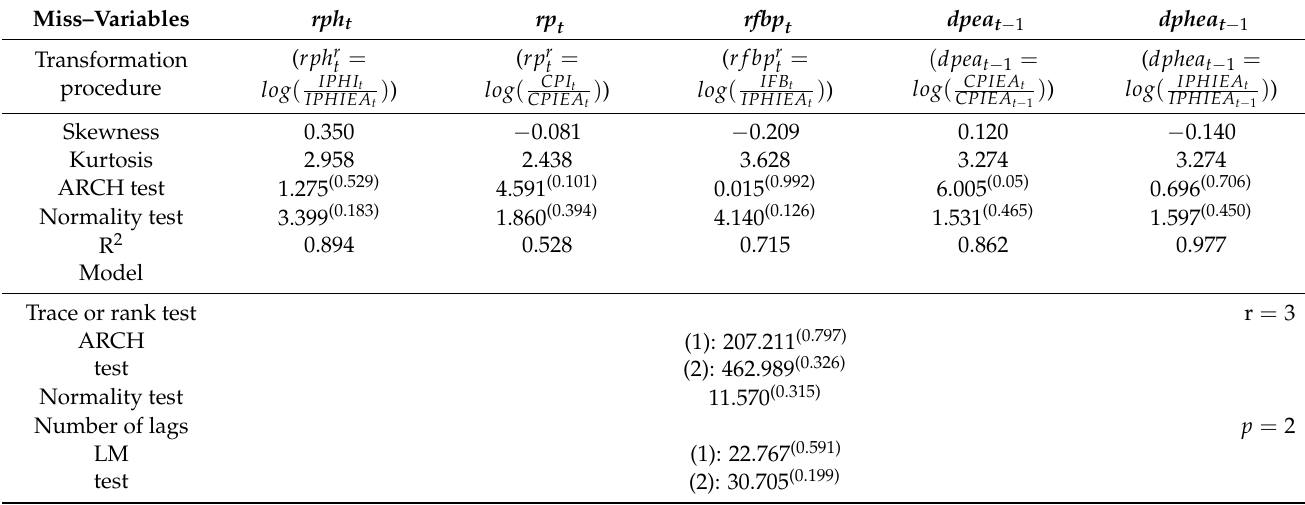
Table A1. Misspecification test of real price indices for the